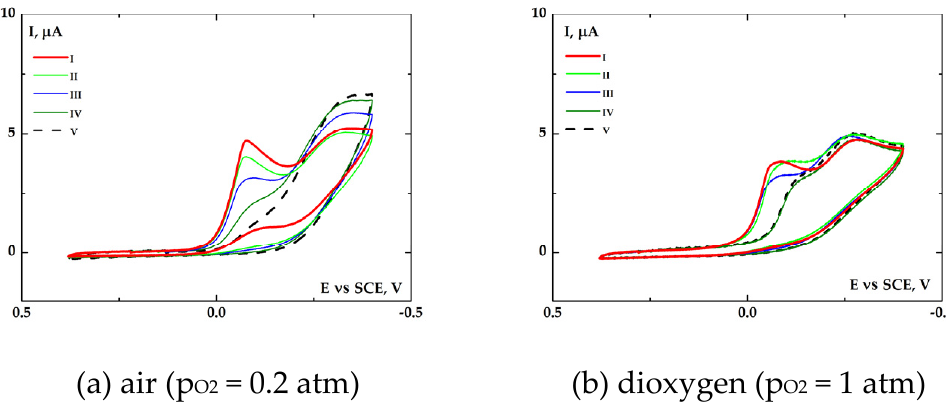
Figure 4. Cyclic voltammograms in acetonitrile (0.1 M Et 4 NClO 4 ) for iron species formed in a reaction of 1 mM [(salen)Fe II ] MeCN with O 2 over time. ( a ) Air (p O2 = 0.2 atm) atmosphere, ( b ) dioxygen (p O2 = 1 atm) atmosphere. Scan rate, 0.1 Vs − 1 , GCE (0.008 cm 2 ); SCE vs. NHE, +0.242 V, cathodic scans. Oxygenated catalyst in time after I—0 min (immediately after aeration), II—5 min, III—30 min, IV—1 h, V—3 h.